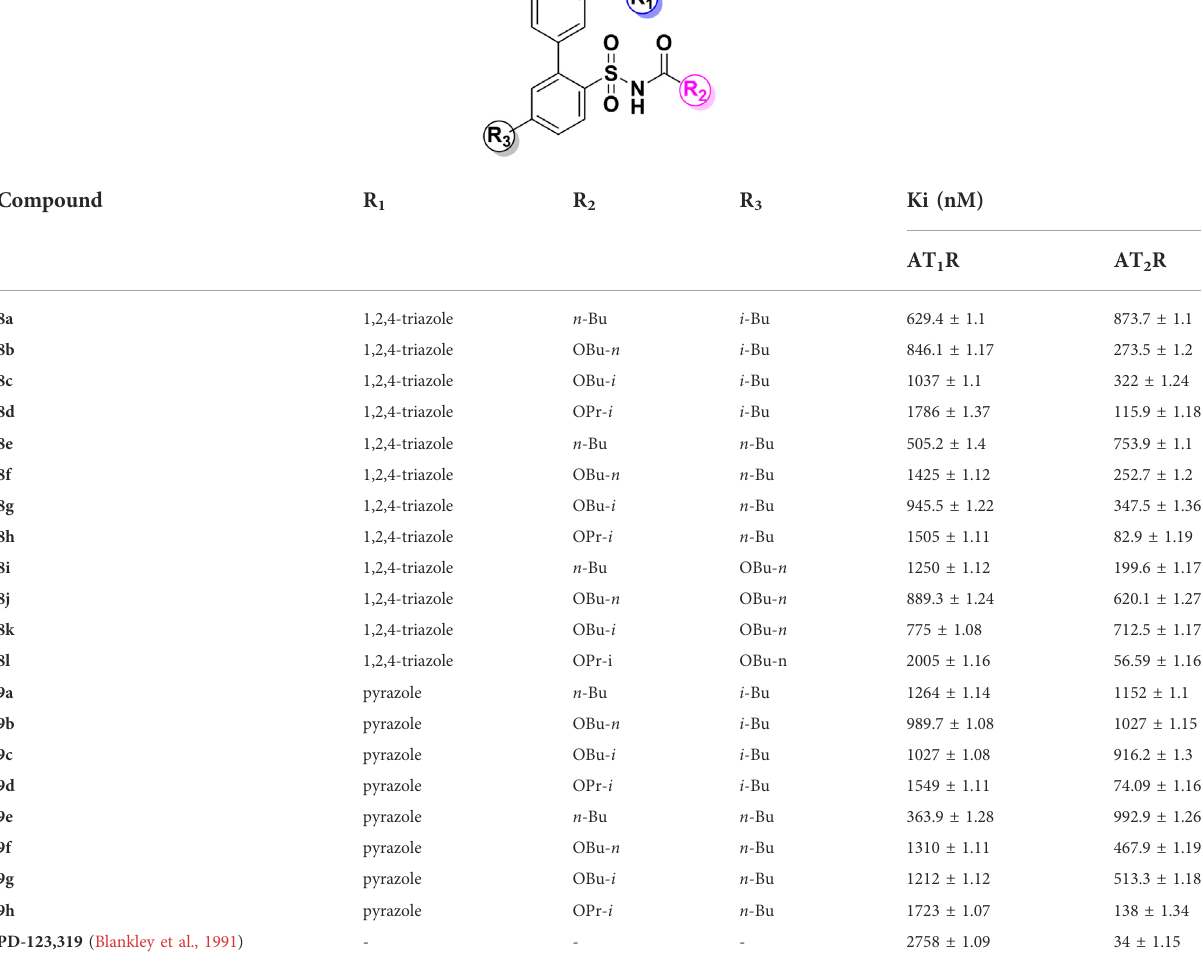
TABLE 1 The binding af fi nity and selectivity of the compound to the AT 2 receptor.